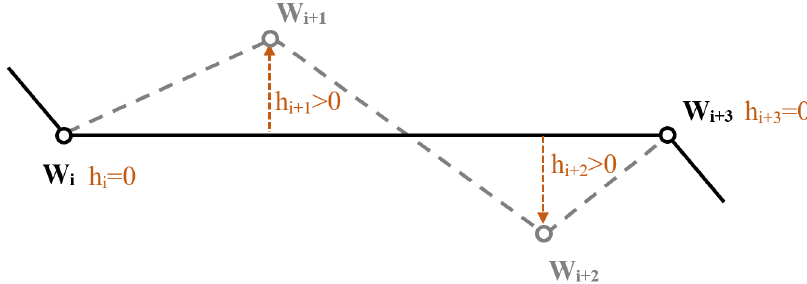
Fig. 6. Fragment of the original and generalised polyline (solid black line − polyline after generalisation; dashed grey line − rejected sides of the original